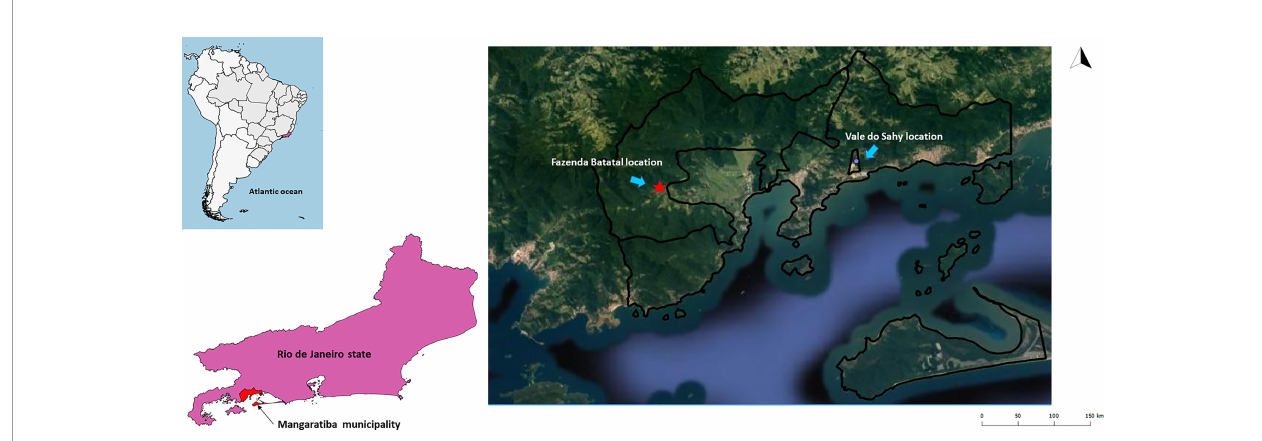
FIGURE 1 | Mangaratiba municipality study locations in 2012 and 2015. The red star represents the area where acute CD occurred in 2012. The blue dot is where the Cunhambebe Park is located. Data source: Instituto Brasileiro de Geogra fi a e Estat ı ́ stica — IBGE (www.ibge.gov.br); Google Earth (https://www.google.com.br/